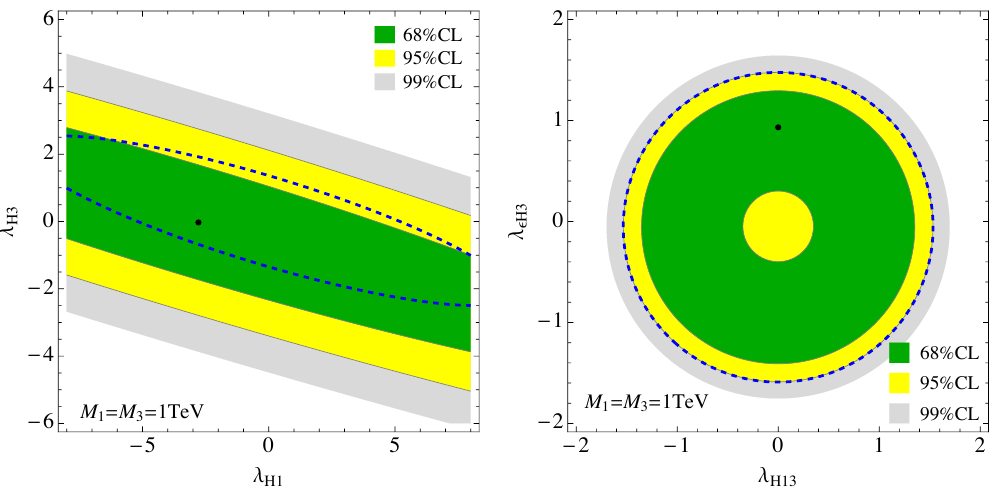
Figure 7 . Limits on LQ potential couplings from oblique corrections and Higgs measurements. In each panel, the other two couplings have been marginalised. The black point represents the best-fit point while the dashed blue contours are the prospects for 95%CL limits after